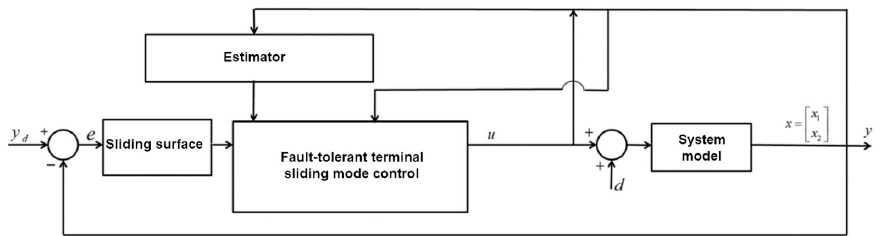
Figure 2. Block diagram of disturbance-observer-based fault-tolerant terminal sliding mode control for vibration suppression of non-local strain gradient nano-beams.